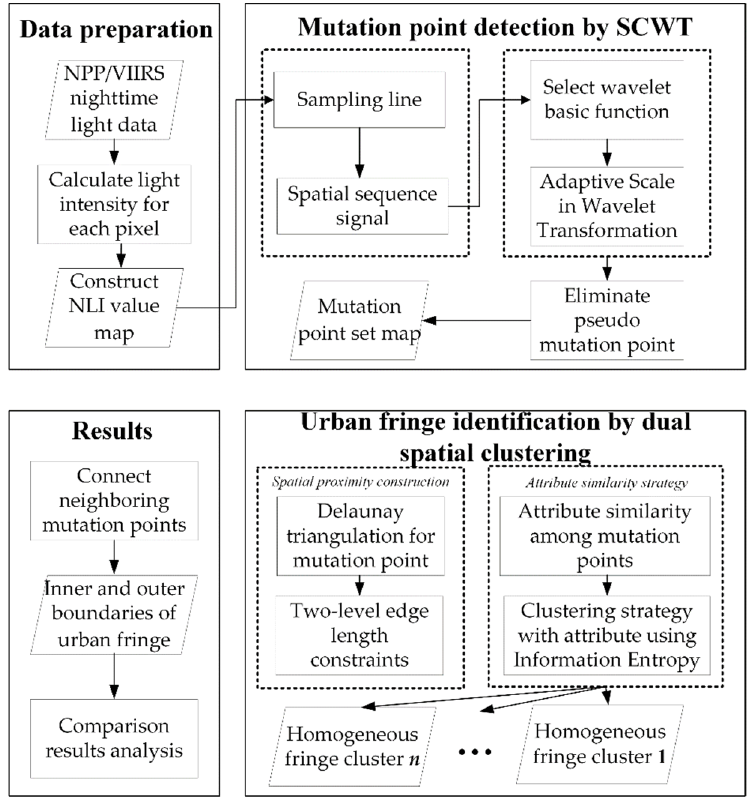
Figure 1. The sketch of the model to detect the urban fringe.